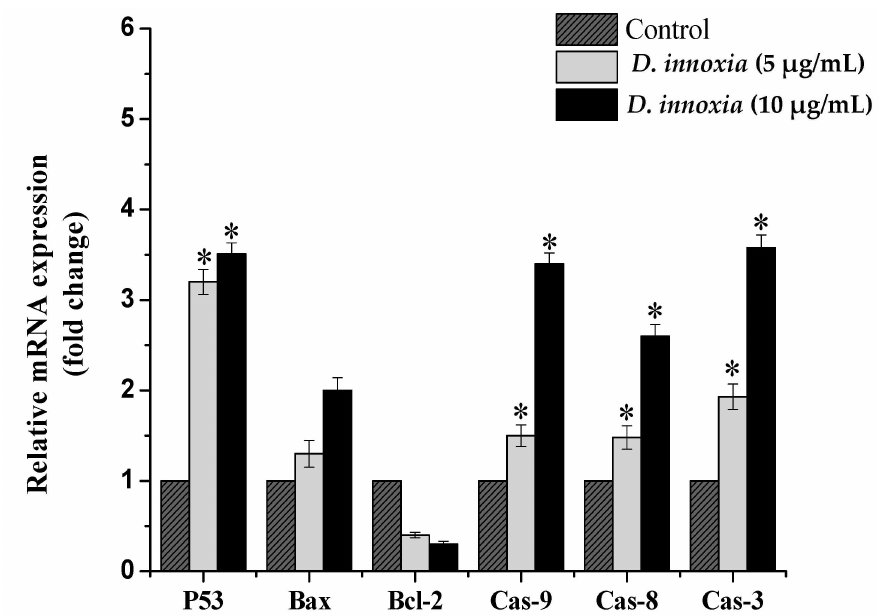
Figure 4. Gene expression levels in LoVo cells, treated with 5 and 10 µ g/mL of D. innoxia for 48 h. Apoptosis related gene expression levels of p53, bax, bcl-2 and caspases 9, 8, 3 were determined by quantitative real-time PCR. GAPDH was used as an internal control. The significant differences from control are indicated by * p < 0.05.